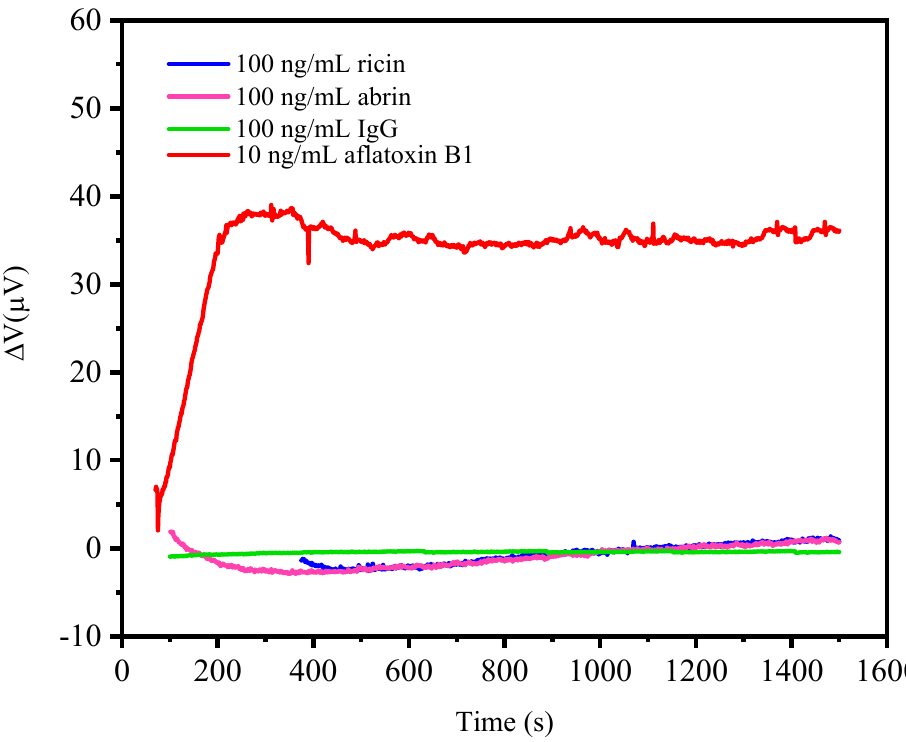
Figure 10. The specific detection results of ricin, abrin, and IgG at concentrations of 100 ng/mL by microcantilever biosensors functionalized with aflatoxin B1 antibody.